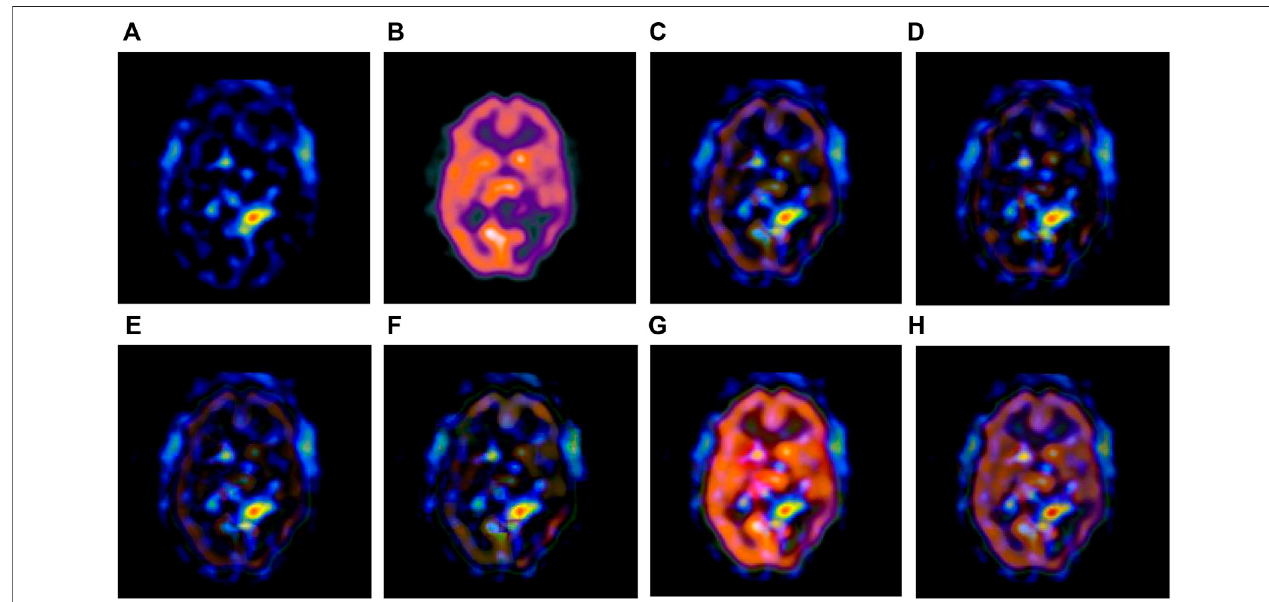
FIGURE5| Fusionresultsofthethirdgroup. (A) SourceimageSPECT-TL3 (B) SourceimageSPECT-TC3 (C) LaplacianPyramid (D) DWT-DBSS (E) SIDWT-Haar (F) Morphological Difference Pyramid (G) SR (H) GA-SR.